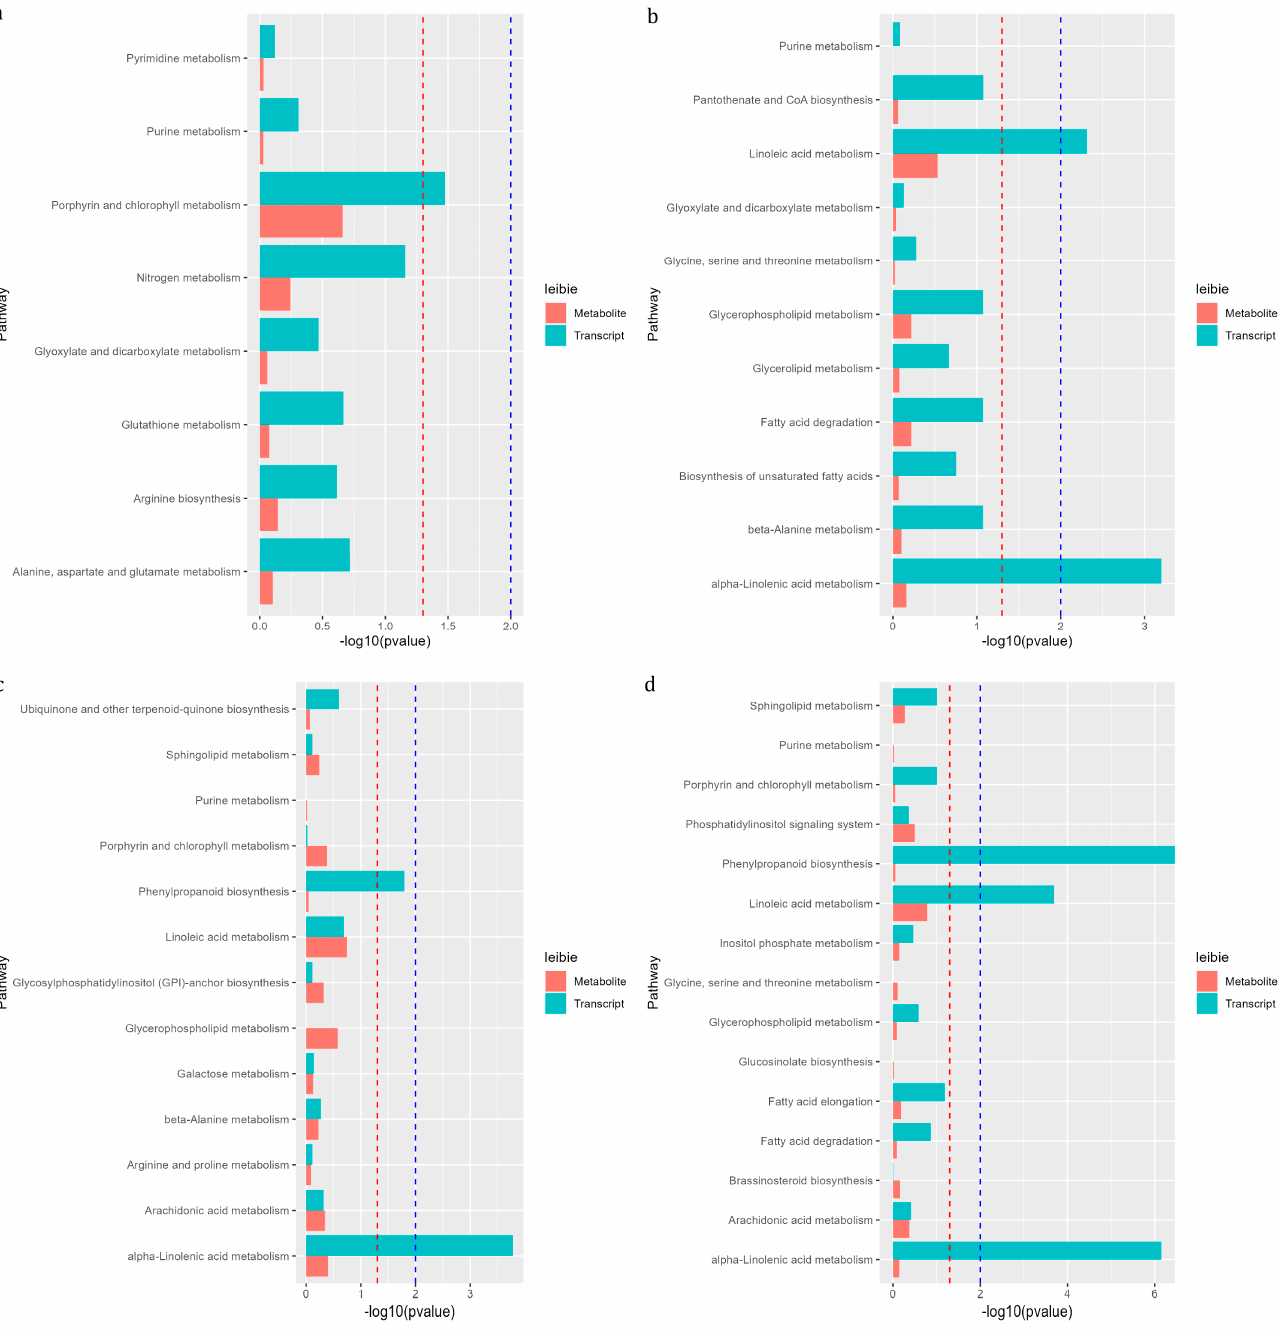
Figure 10. Pathways with simultaneous annotation of DEGs and DMs. Horizontal is − log 10 ( p- value) and ordinate is pathway name. Red leibie is metabolite, blue leibie is transcript, red line means p value < 0.05 and blue line means p value < 0.01. ( a ) bx1 vs. ck1; ( b ) bx2 vs. ck2; ( c ) bx3 vs. ck3; ( d ) bx4 vs. ck4.